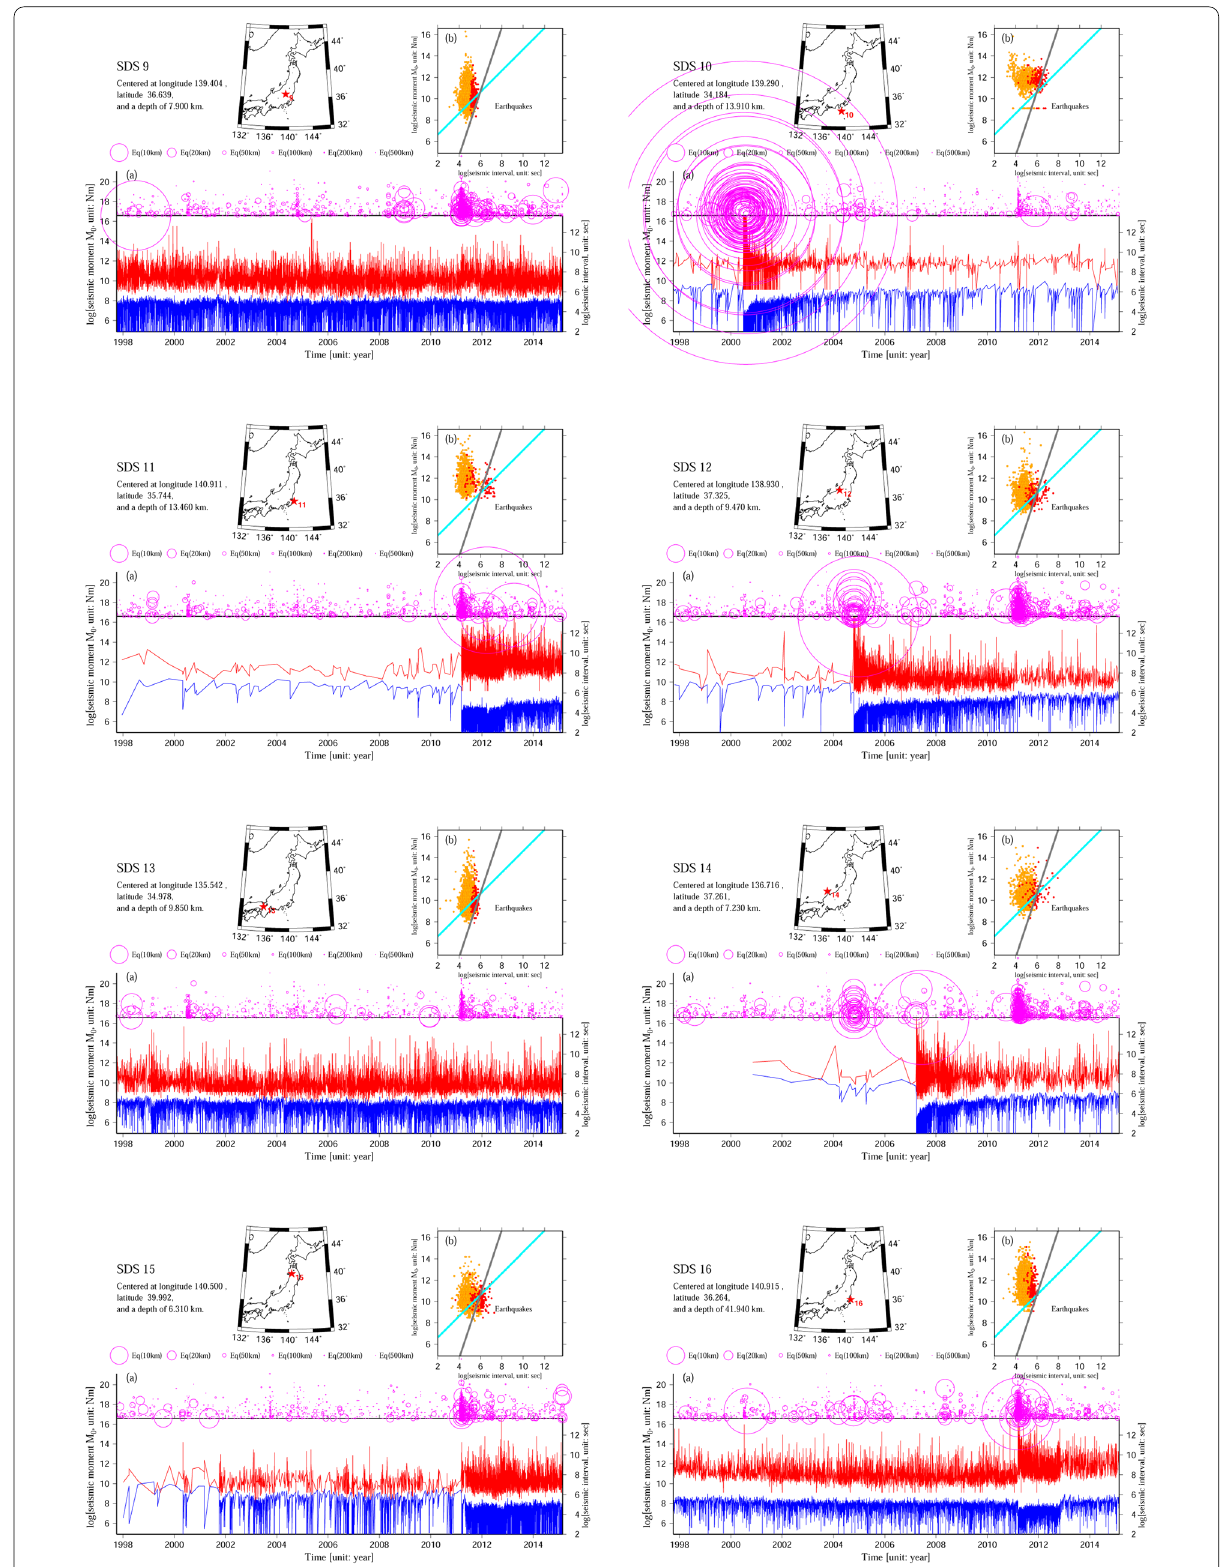
Fig. 4 Calculated results of seismic moment and seismic interval at the selected regions of seismicity density spheres